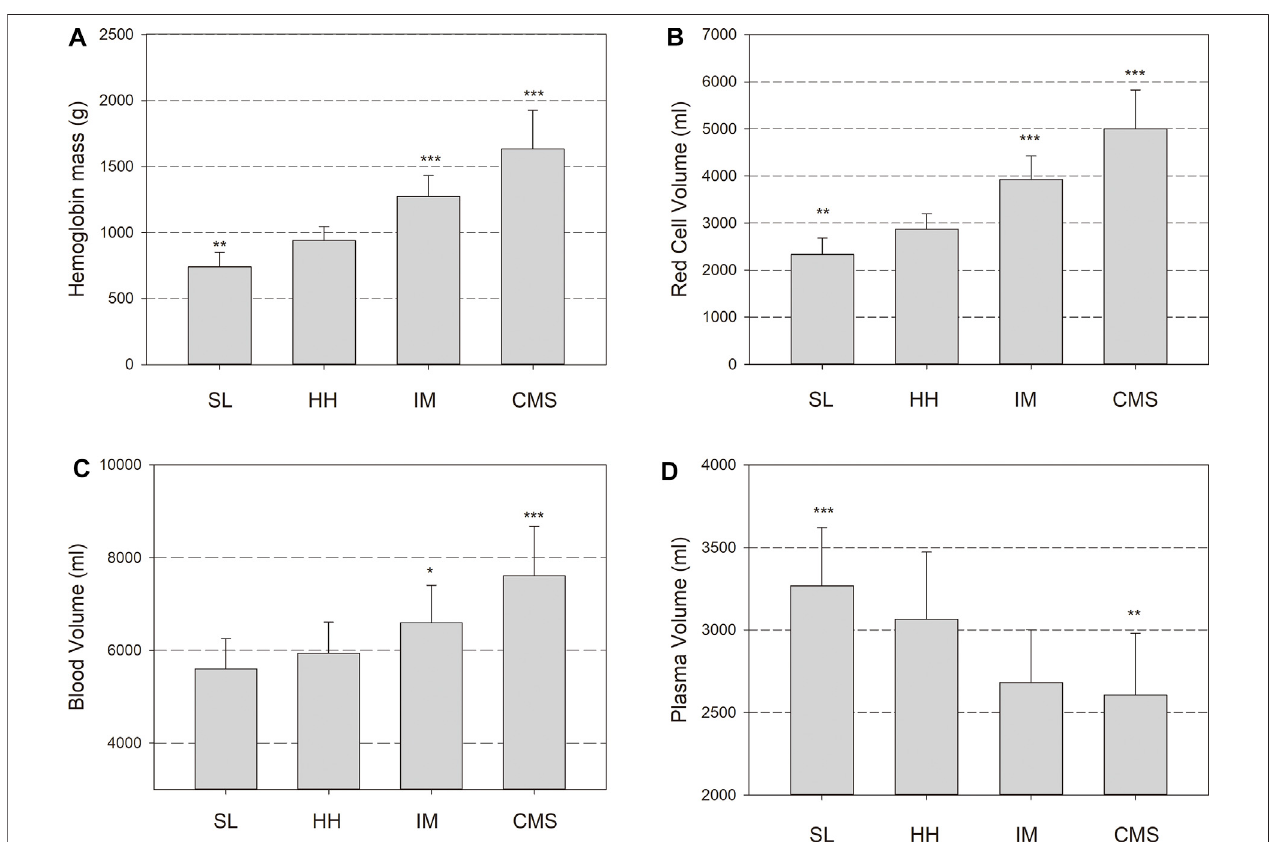
FIGURE 1 | Hemoglobin mass (Hbmass), (A) , red cell volume (RCV), (B) , blood volume (BV), (C) and plasma volume (PV), (D) in sea level (SL) residents, healthy highlanders (HH), intermediate polyglobulic subjects (IM), and patients with chronic mountain sickness (CMS). Signi fi cant differences with respect to the HH group: * = p < 0.05, ** = p < 0.01, *** = p <